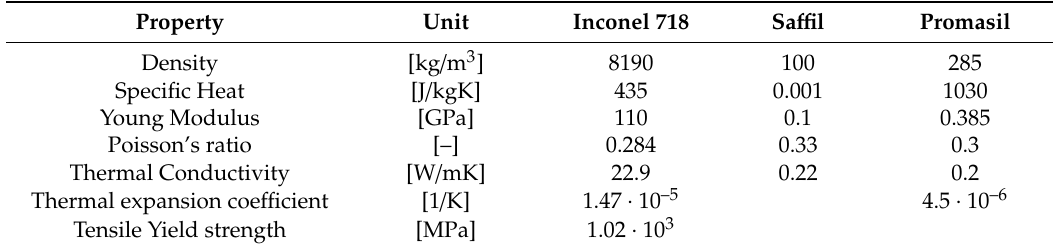
Table 3. C / SiC thermal and mechanical